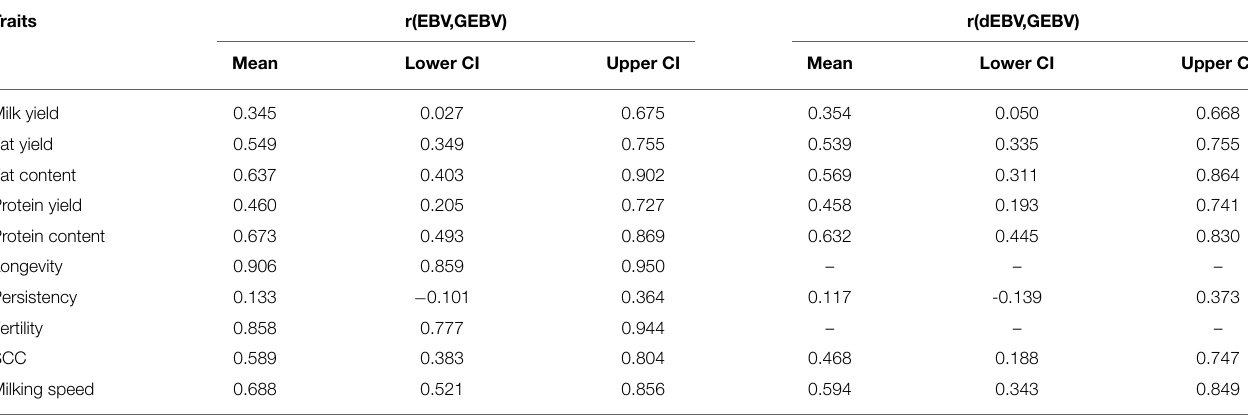
TABLE 2 | Mean accuracies of GEBVs computed from EBVs and dEBVs from the single breed scenario and their 95% confidence intervals computed based on 10,000 bootstrap samples. Traits